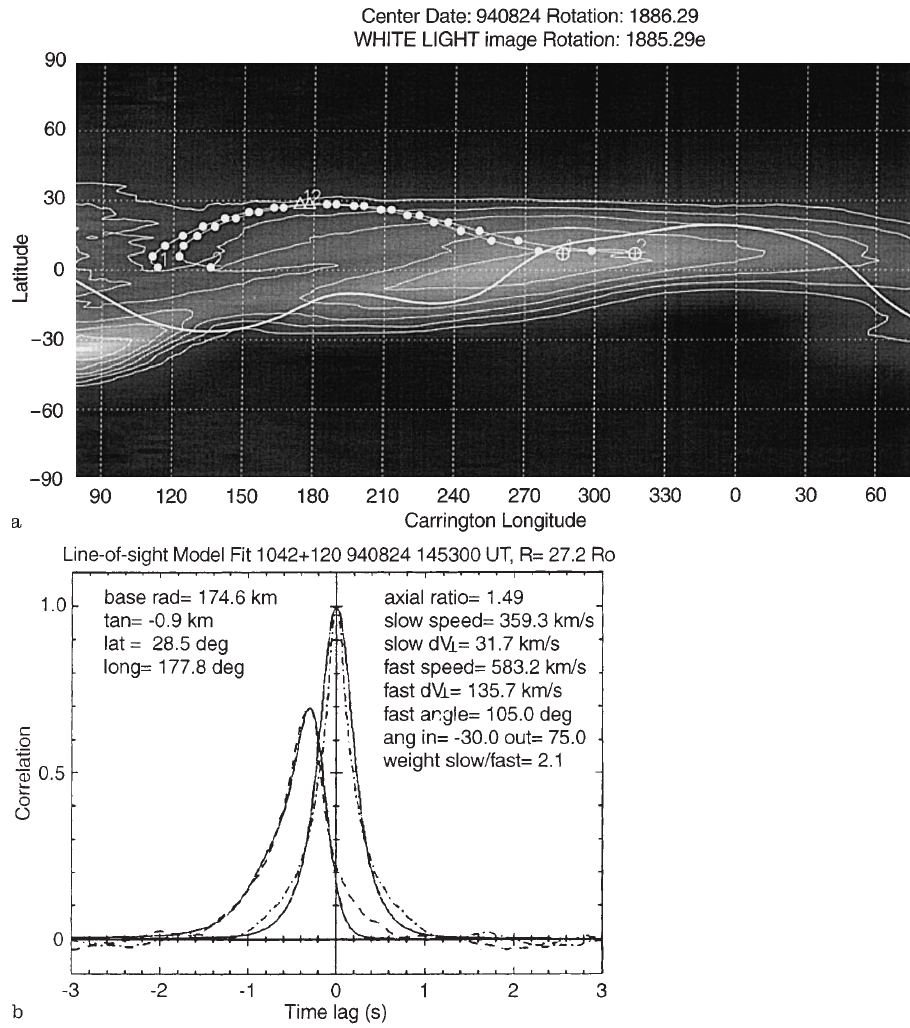
observed correlation functions are shown as broken lines and the results of the model fit as solid lines . The ‘‘fast’’ component is slower and produces more scintillation than would a normal stream, suggesting that a compression region moving at an intermediate velocity is present in